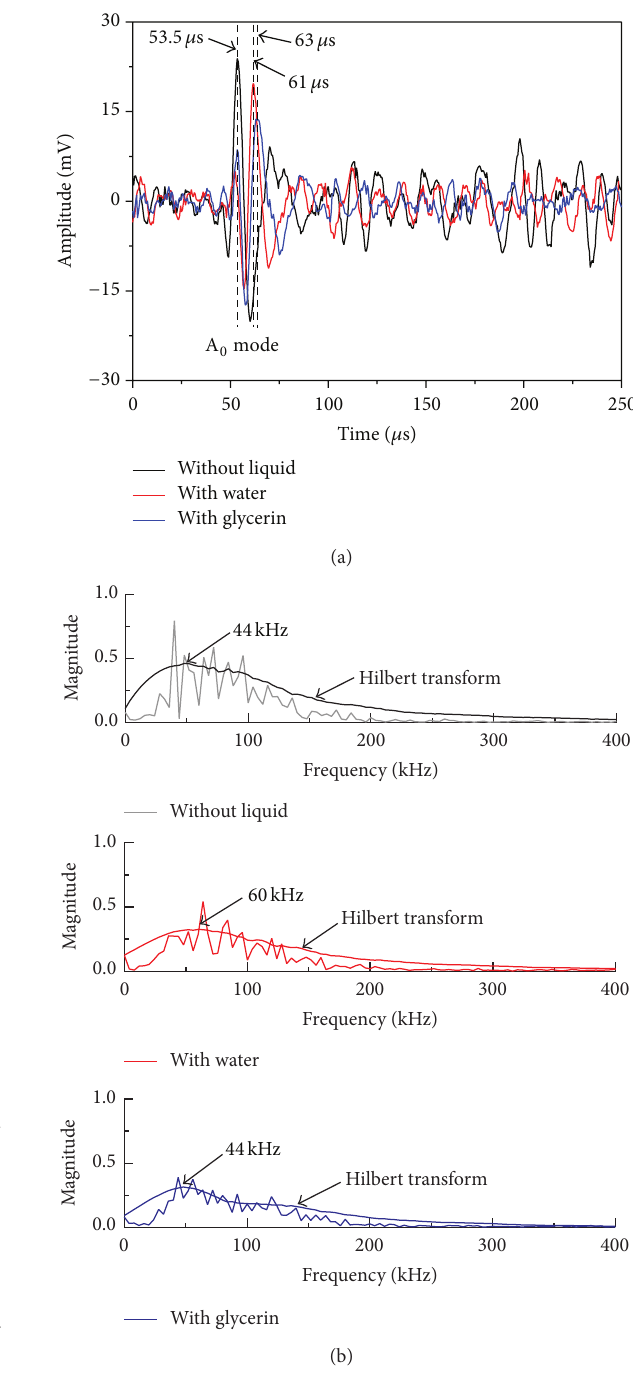
Figure 11: Signals extracted at the impinging point of the center of crack: (a) time domain and (b) frequency domain.